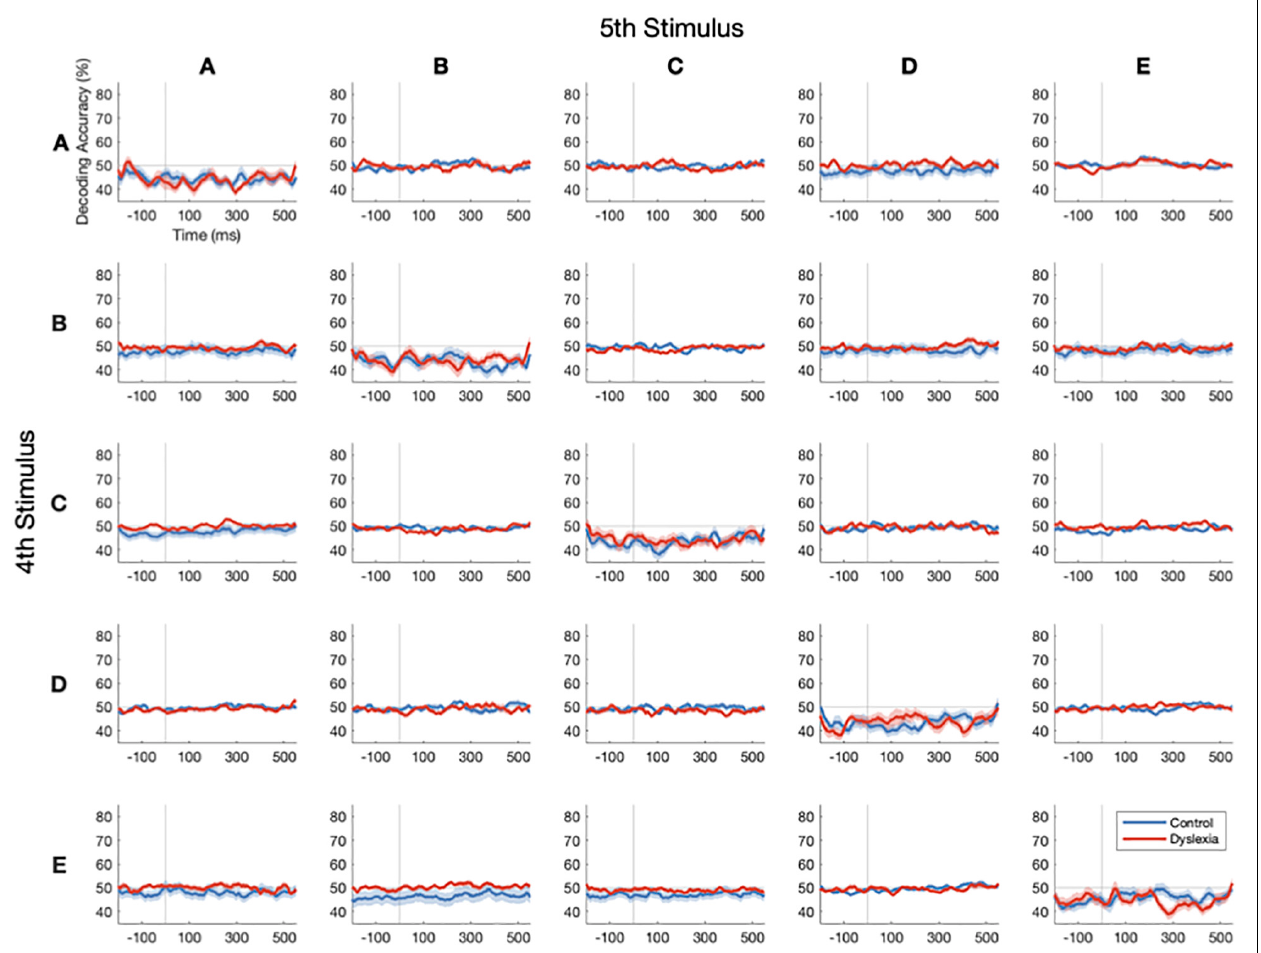
FIGURE 5 | Stimulus-specific standards vs. deviants cannot be decoded with low numbers of trials. Decoding-accuracy time courses for stimulus-specific standard-to-deviant transitions in Control (blue) and Dyslexia (red). Rows indicate the standard stimulus (the 4th in its train) and columns indicate the stimulus that followed it in time, either a deviant 1st or a 5th in the same train. Reliable decoding of standards and deviants above the 50% chance level could not be achieved with the low numbers of stimulus-specific transitions in our paradigm. Along the diagonal, the classification of identical stimuli yields below-chance classification